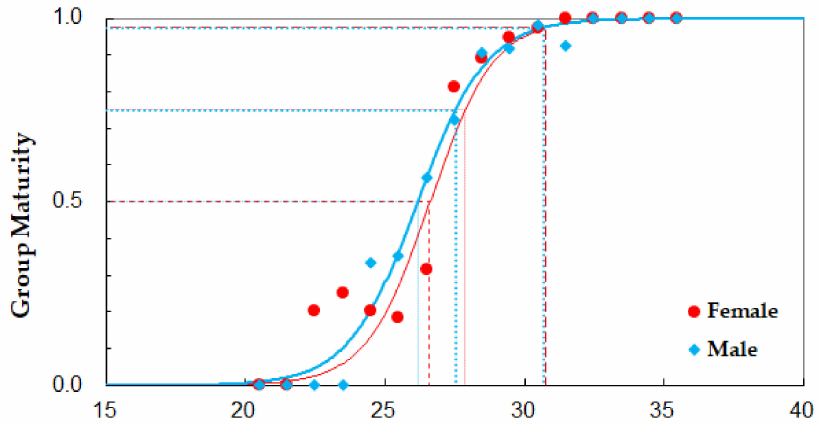
Figure 9. Logistic curve showing the relationship between maturity and DW in ocellate spot skate Okamejei kenojei specimens collected from the West Sea of Korea in 2019 and